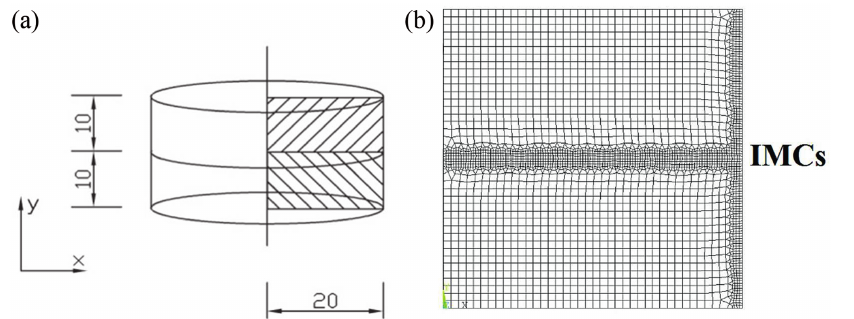
Figure 1: The scheme of Mg/Al joints: (a) geometrical model; (b) meshing